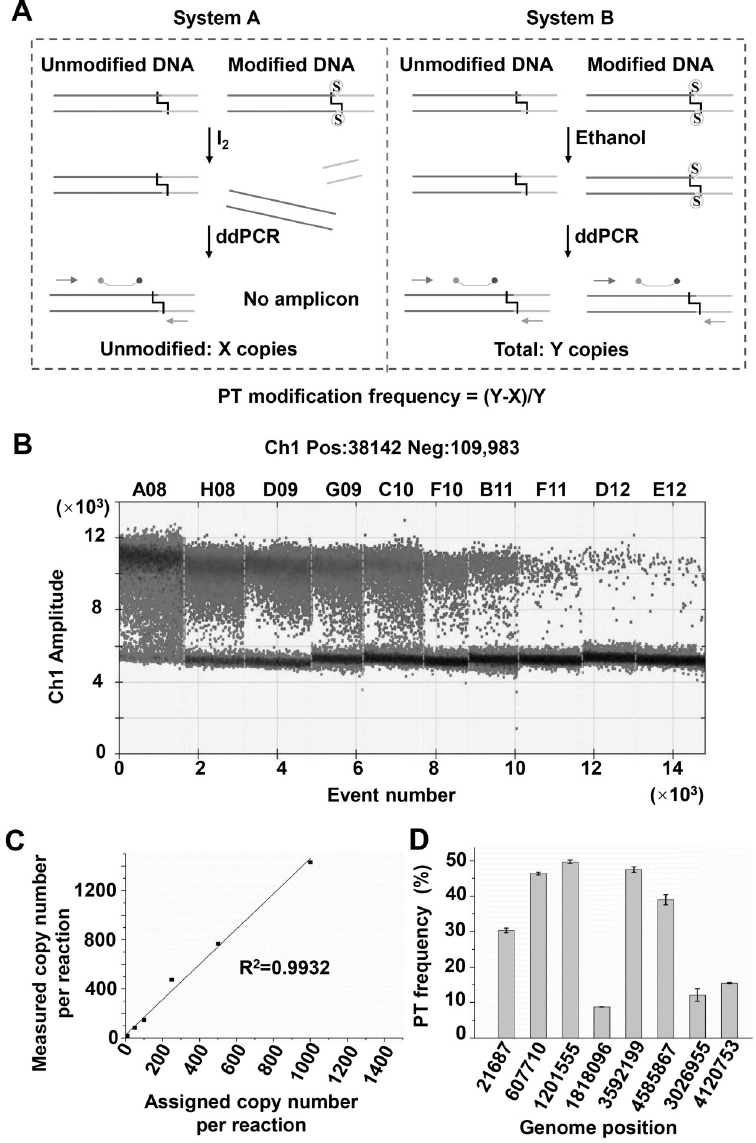
Fig 5. PT-IC-ddPCR quantify PT modification frequency. (A) Schematic diagram of the PT-IC-ddPCR quantified the DNA PT modification frequency at a specific site. Left (System A): DNA sample was firstly treated with iodine, then unmodified DNA was quantified as X copies by ddPCR using the primers and probe; Right (System B): Total DNA was quantified as Y copies by droplet digital PCR using the same primers and probe; the modified DNA was calculated as Y-X and the PT modification frequency was calculated as (Y-X)/Y. (B) The one-dimensional (1D) scatter plot of serial concentration of E . coli B7A by droplet digital PCR. (C) Dynamic range and correlation of the ddPCR assay for quantification of PT modification frequency at 1818096 loci in E . coli B7A genome. The observed positive droplets matched well with the predicted values according to Poisson statistics (R 2 = 0.9932). (D) The PT modification frequency of 8 loci (G1-G8), each value was the mean based on at least three measurements.